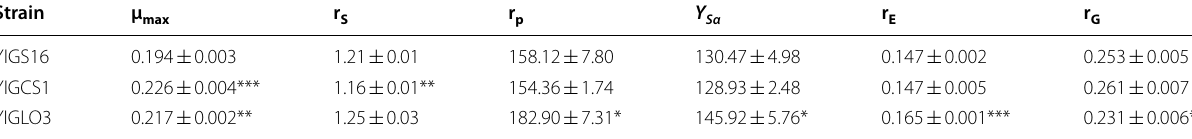
Table 2 Physiological parameters of YIGS16, YIGCS1 and